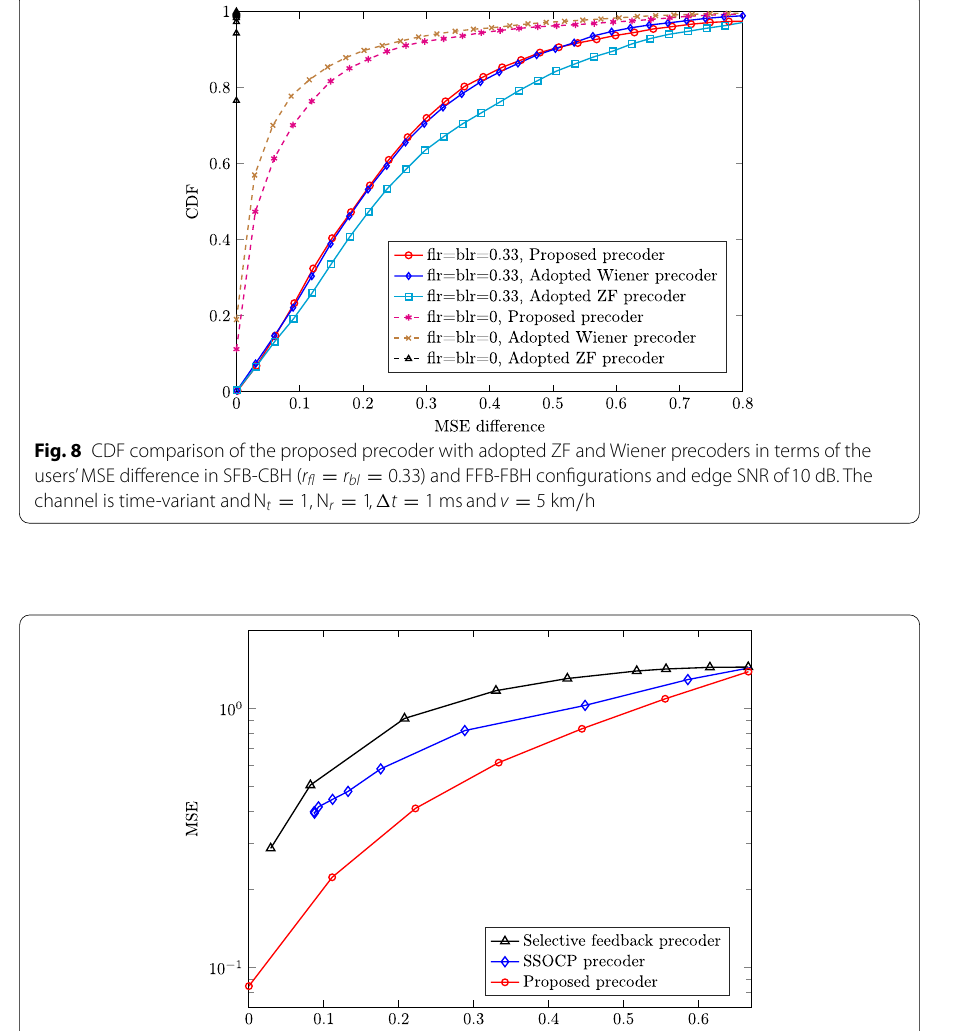
the Wiener precoder. As expected, in the FFB-FBH configuration, the ZF precoder